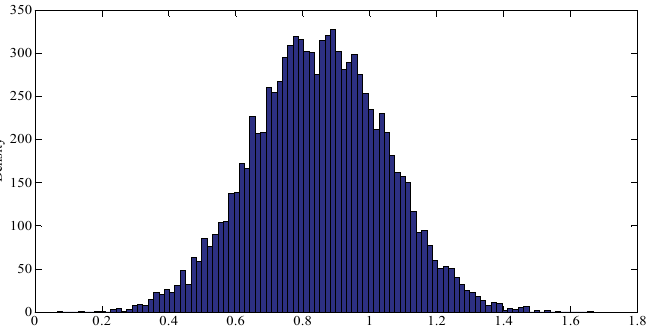
Figure 9. The Load PDF of each bus demand.